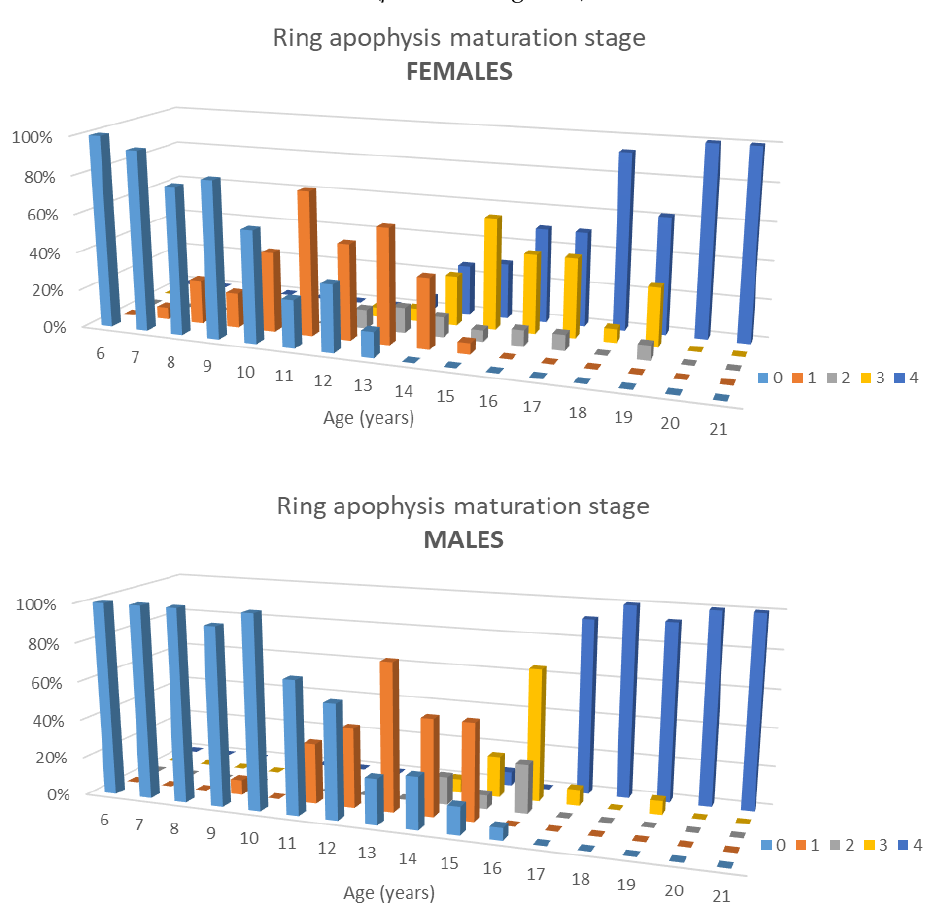
Figure 4. A 3-D histogram showing the percentiles of the different maturation stages of the apophyseal ring in females and males at different ages.